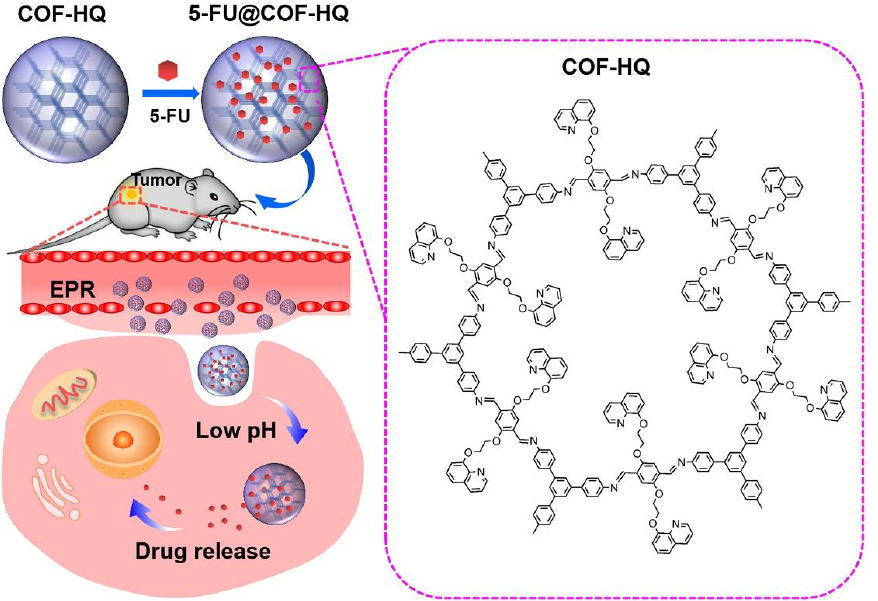
Figure 7. pH-responsive COF-HQ for 5-FU loading and release [76]. Reprinted with permission from ref. [76]. Copyright 2020 Elsevier.